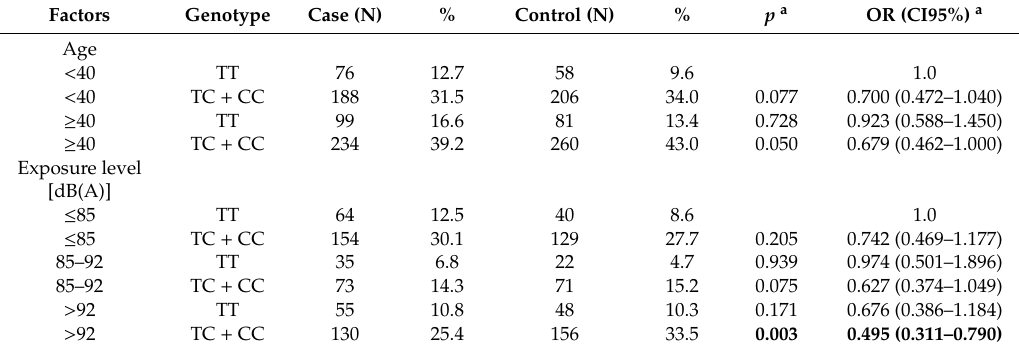
Table 6. Crossover analysis of the interaction between rs6489721 and other factors on NIHL